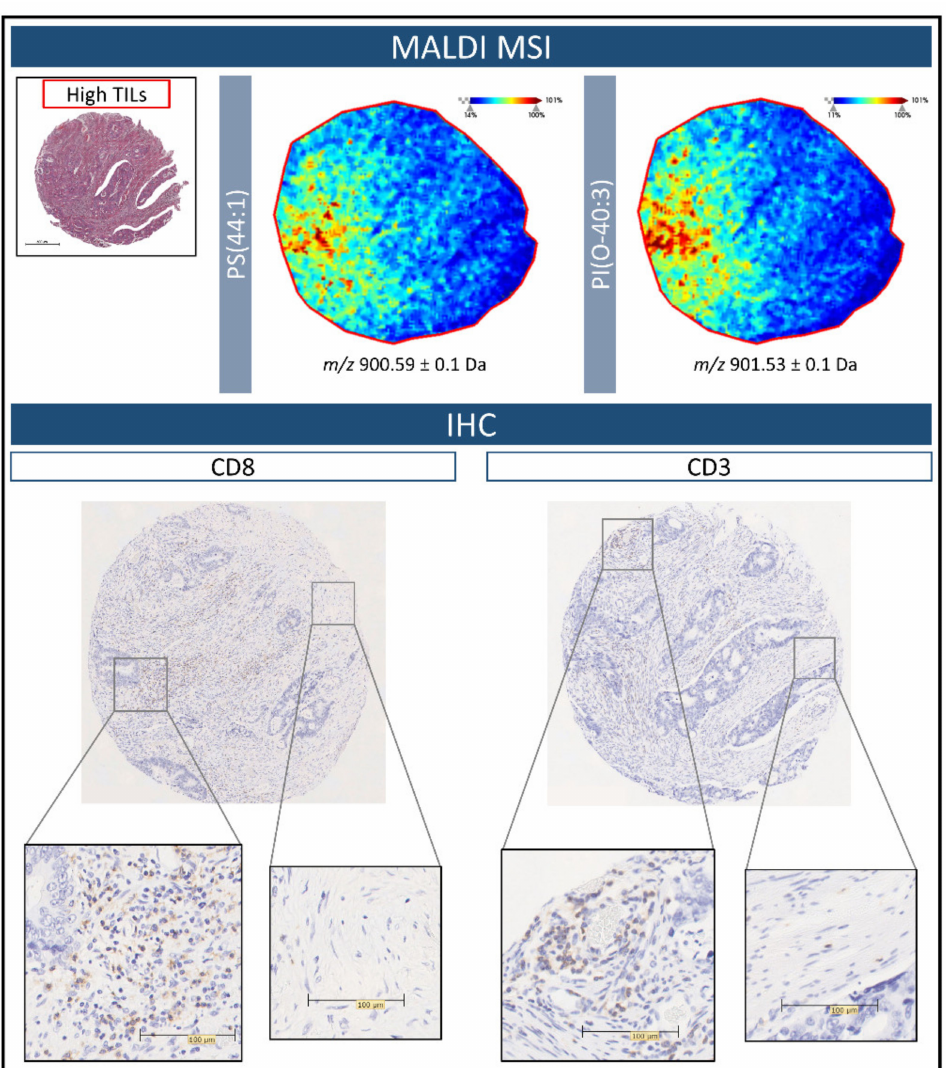
Figure 5. ( Top ) Example MALDI-MS images illustrating the distribution of m / z 900.6 [PS(44:1)], and m / z 901.5 [PI(O-40:3)] within colorectal cancer tissue of the High tumour infiltrating lymphocyte (TIL) group. The H&E stained image is provided in order to reference the overall tissue morphology. ( Bottom ) Immunohistochemistry images for CD3 and CD8 performed on further sections of the colorectal cancer tissue microarray. The greatest number of TILs, in particular CD8, are found within the regions highlighted by the MALDI-MS images. Zoomed insets have been provided in order to better visualize the presence of the TILs. Scale bars are